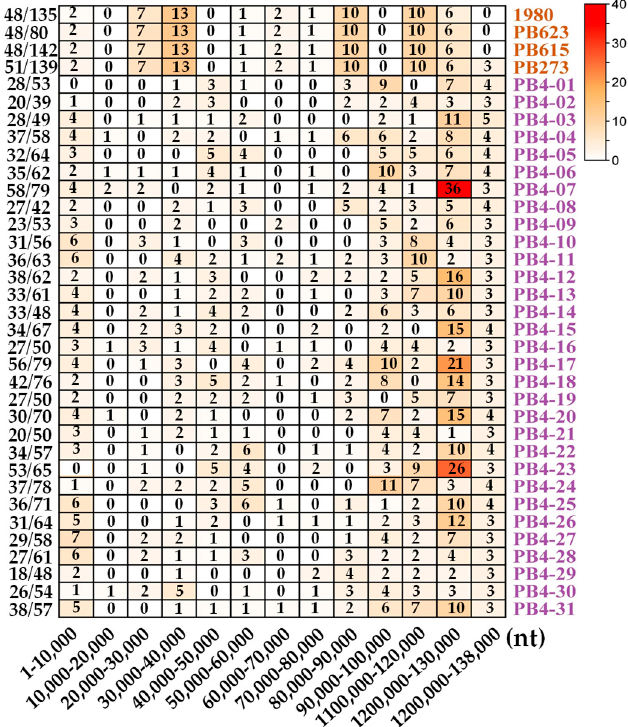
Figure 5. SNPs in the single-ascospore-isolation offspring of strain PB4 compared with strain PB4.